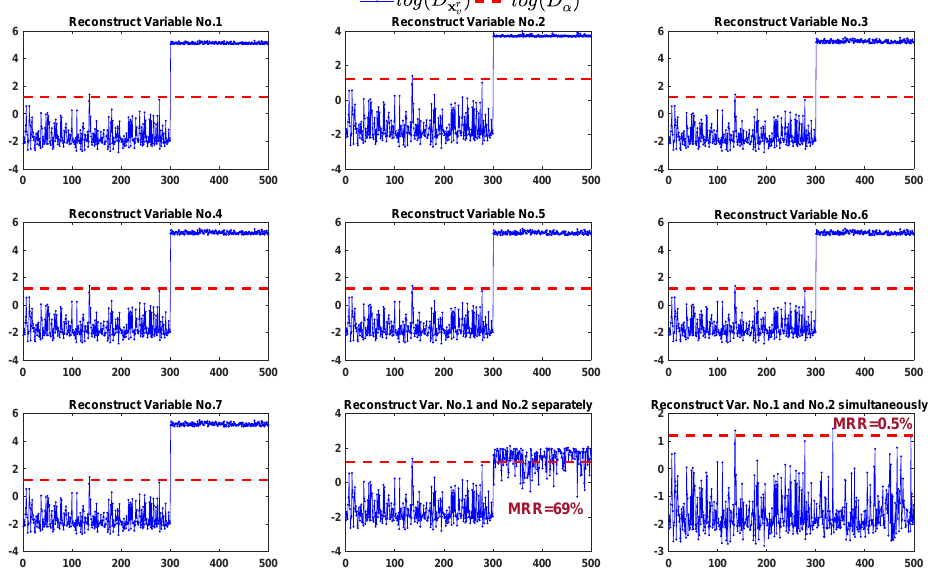
Figure 7. The fault detection results by eliminating faulty variable for case